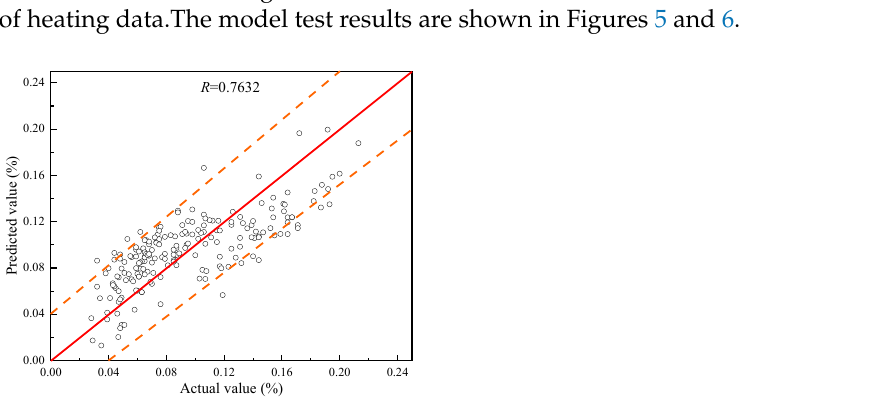
Figure 5. Comparison of predicted and actual values of end-point carbon content for ANN.